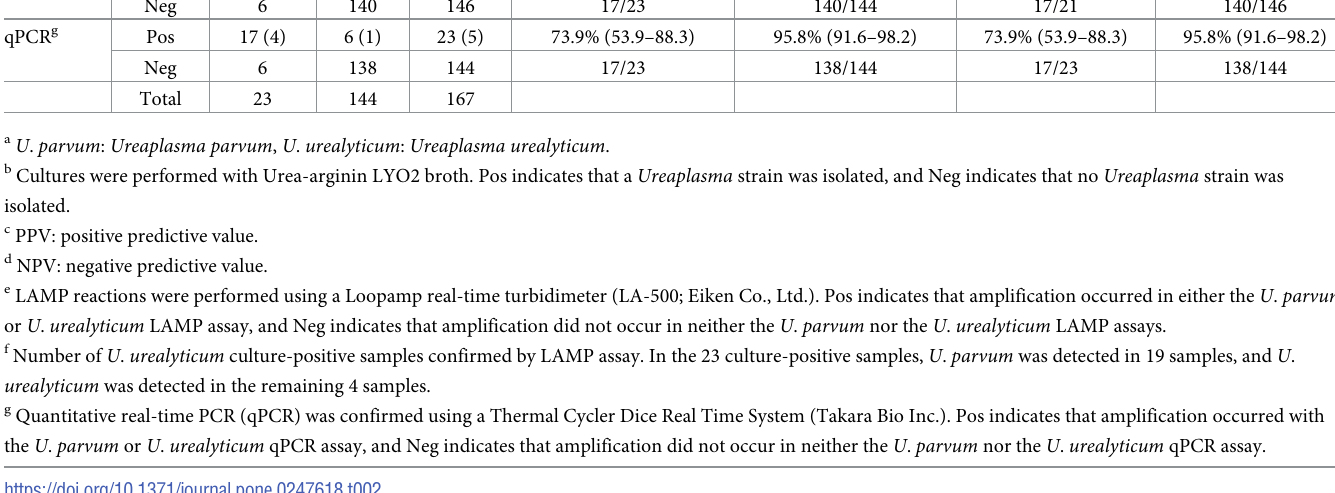
Table 2. Comparison of LAMP, quantitative real-time PCR, and culture results from 167 nasopharyngeal swab specimens. Detection of U . parvum or U . urealyticum a